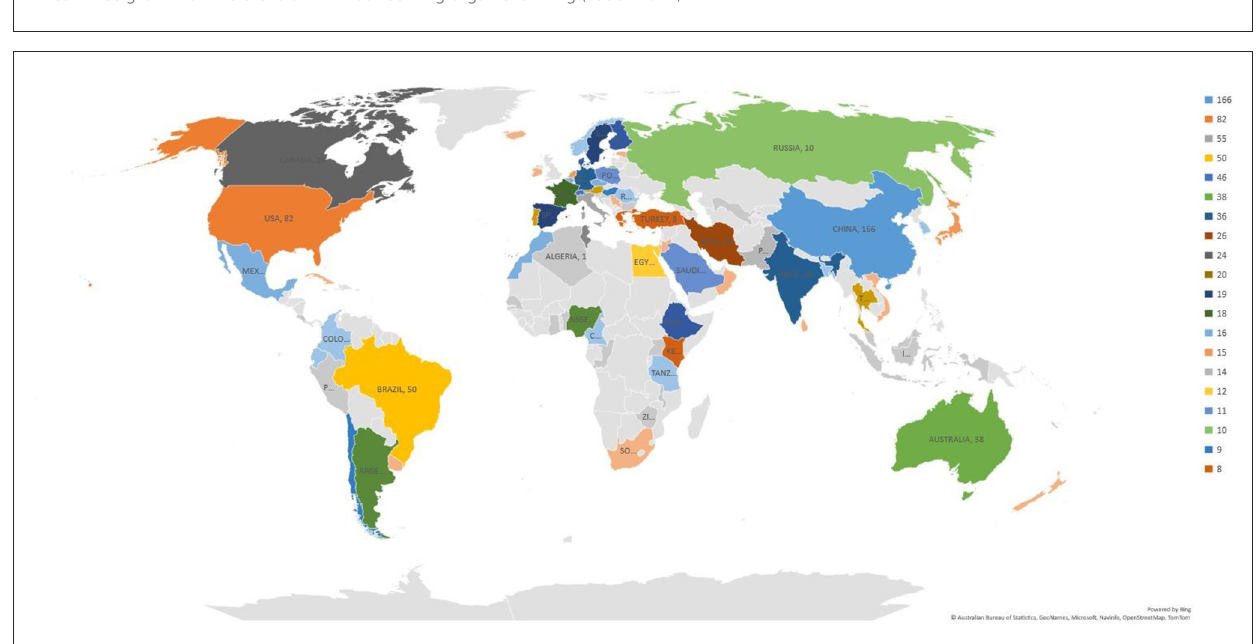
FIGURE2 Country-wise distribution of available literature on AMF and organic